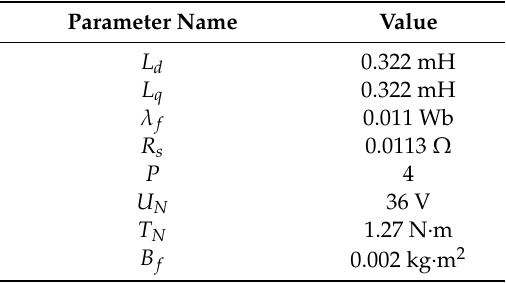
Table 1. Parameters of tested permanent magnet synchronous motor